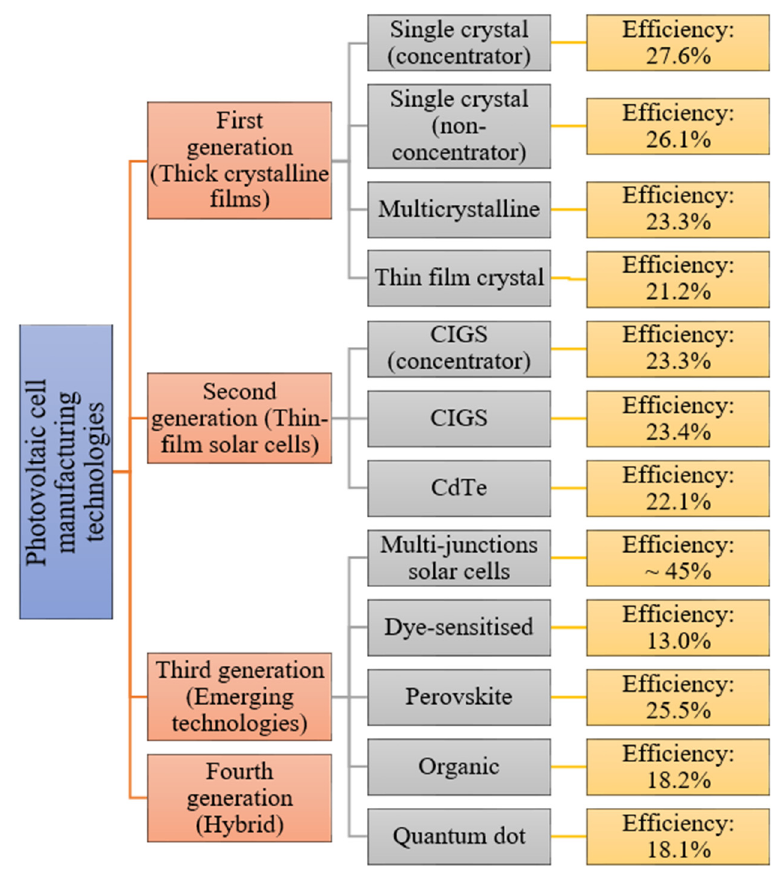
Figure 3. Examples of photovoltaic cell efficiencies [16].